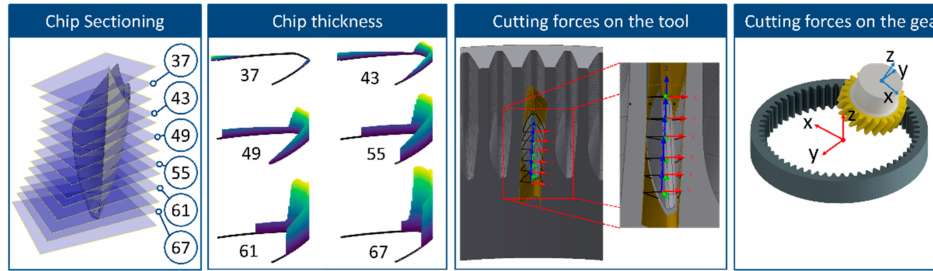
Figure 4. Cutting force calculation